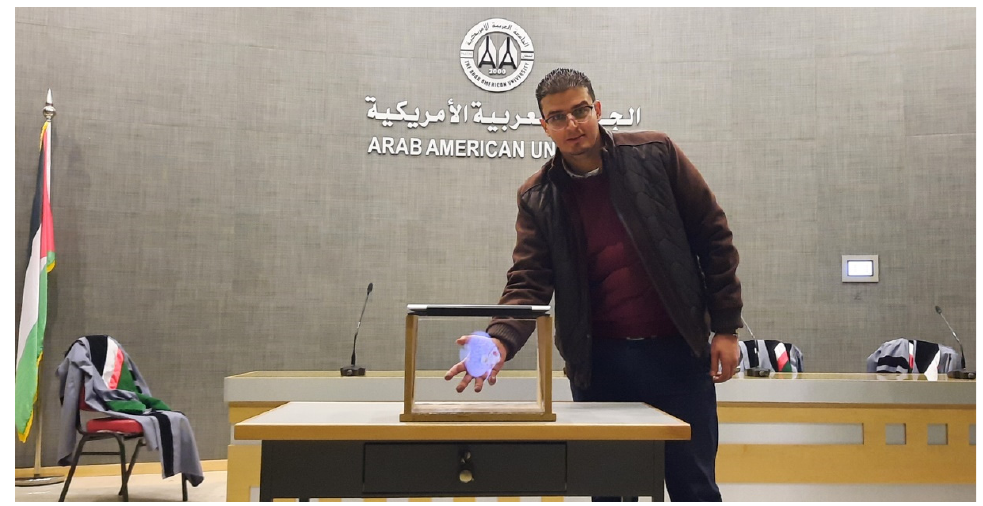
Figure 5. Demonstration of hologram experiment showing a fish.